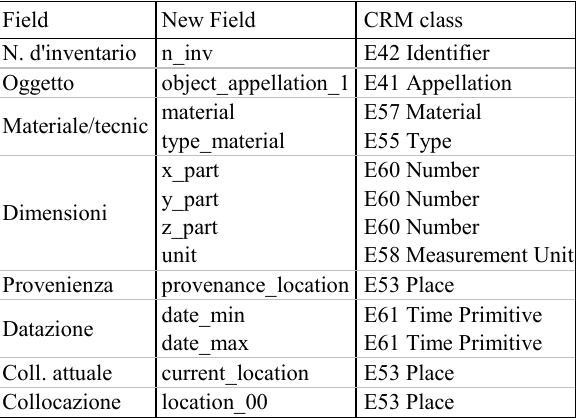
Table 1. Mapping of metadata that are available from the